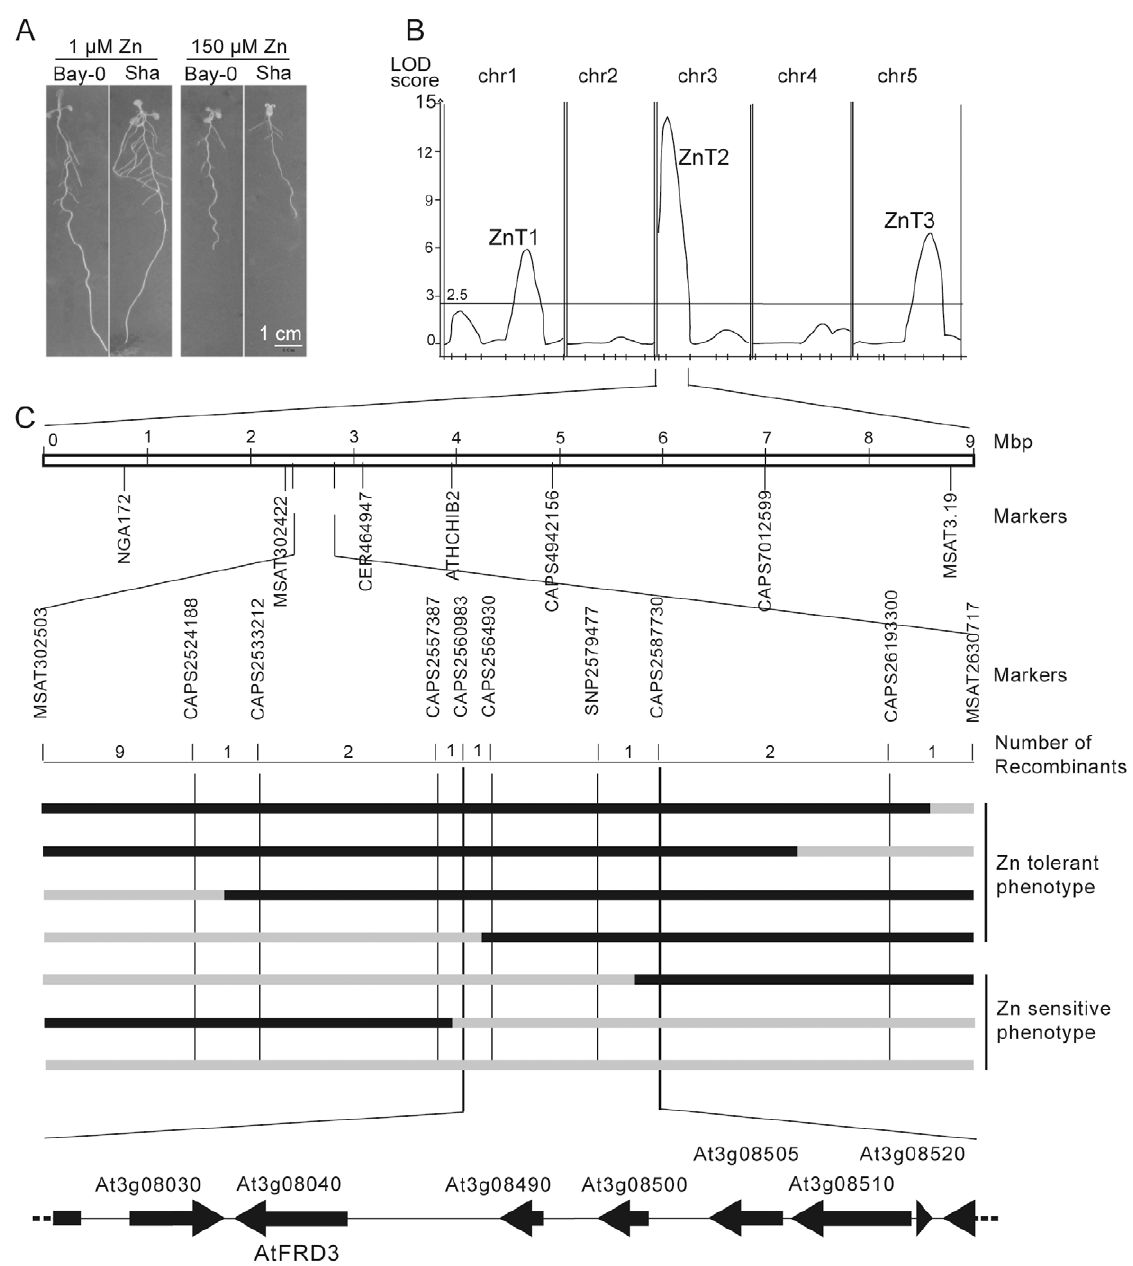
Figure 1. QTL and fine-mapping of the ZnT2 locus. (A) Root phenotype of 10-day-old Bay-0 and Sha plants grown on agar plates containing 1 m M or 150 m M Zn. Bay-0 is more Zn-tolerant than Sha. Scale bar, 1 cm. (B) QTL map for the response of the primary root length to Zn (relative primary root length of plants grown at 150 m M and 1 m M Zn), evaluated in a sub-set of 165 RILs from the Bay-0 6 Sha RIL population. The map was obtained by composite interval mapping and a LOD threshold of 2.5 obtained from permutation. (C) Fine mapping of the ZnT2 QTL. ZnT2, initially mapped between markers NGA172 and MSAT3.19, was localized between MSAT302503 and MSAT2630717 and narrowed down to between CAPS2560983 and CAPS2587730 by recombinant screening. This 23 kb-long region encompasses 7 full-length genes including FRD3 . Zn tolerance phenotypes of recombinant plants with informative genotypes are given. Black and grey bars represent Bay and Sha genomes, respectively. doi:10.1371/journal.pgen.1003120.g001 (Figure 3C). We therefore favor the hypothesis that in planta , the The apparent dominant negative effect of FRD3 Sha in the effect of down regulation of the FRD3 Sha transcript predominates citrate efflux assay in Xenopus oocytes may seem inconsistent with over the dominant negative effect of the FRD3 Sha protein. On this the observed recessive character of the Zn-sensitive phenotype point, no accession harboring only the non-synonymous substitu- associated with the FRD3 Sha allele in planta . Compared to the tions leading to the non-functional FRD3 Sha isoform was found control condition, transcript levels of the FRD3 Sha allele are 2.5 to 5 times lower in response to Zn excess, while transcript levels of after screening 109 A. thaliana accessions. This suggests that these the FRD3 Bay allele are 1.5 to 2 times higher in the same condition mutations are strongly selected against and that a mutation that